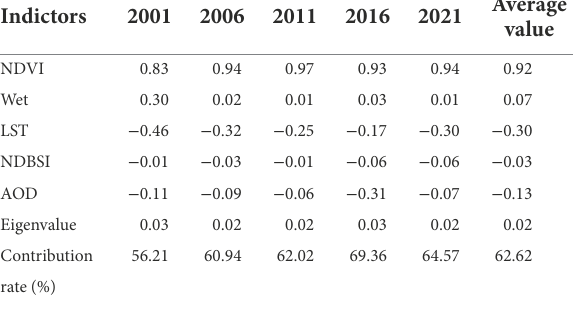
TABLE 3 Results of the first principal component analysis.